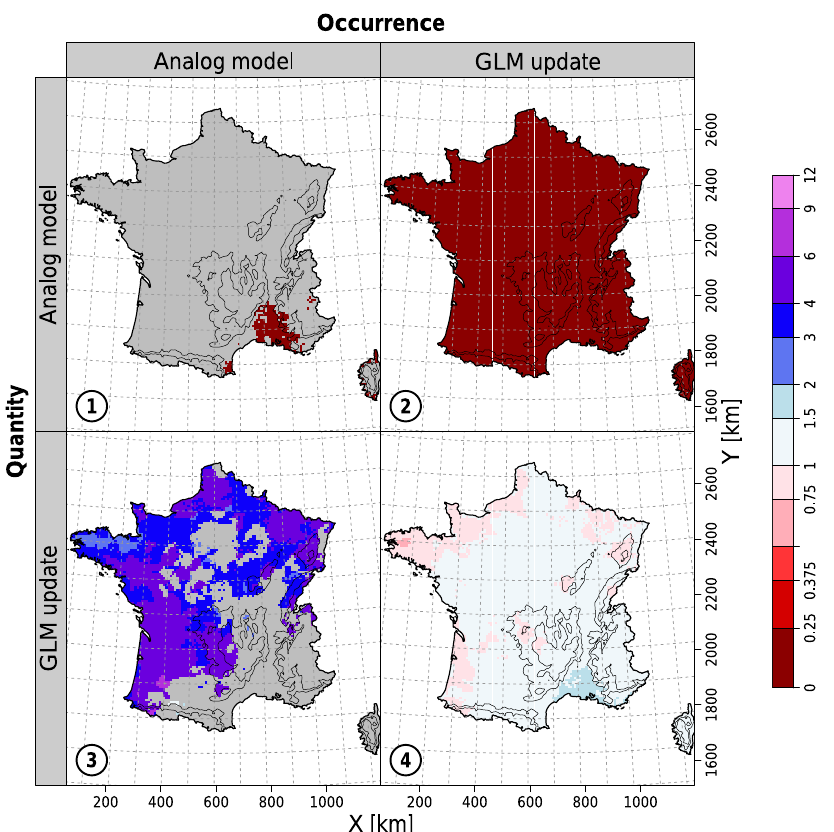
Figure 6. Ratio between the mean amount obtained for all days belonging to a given case and the overall mean precipitation amount. The four cases and gray grids: same as in Fig. 5.